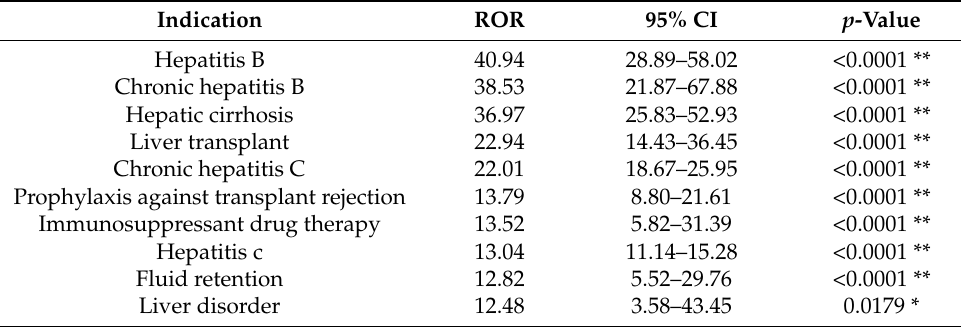
Table 5. Top 10 indications associated with liver malignant